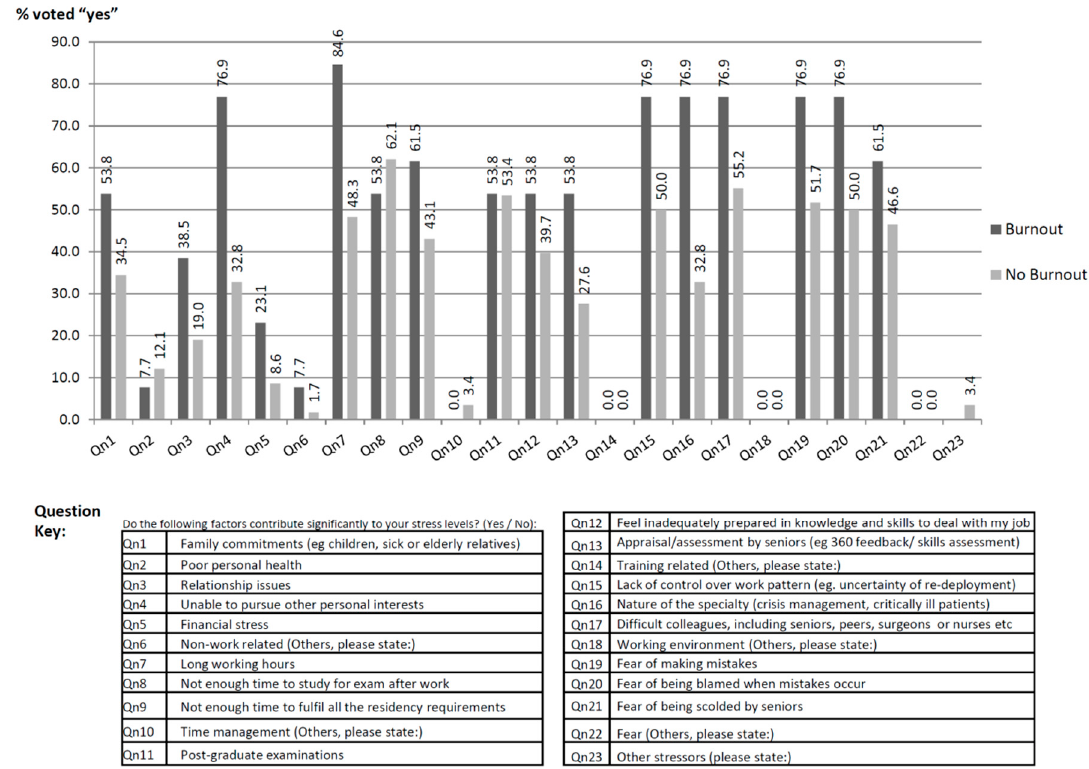
Figure 3. Frequency of stressors reported in burnt out and non-burnout anesthesiology residents.